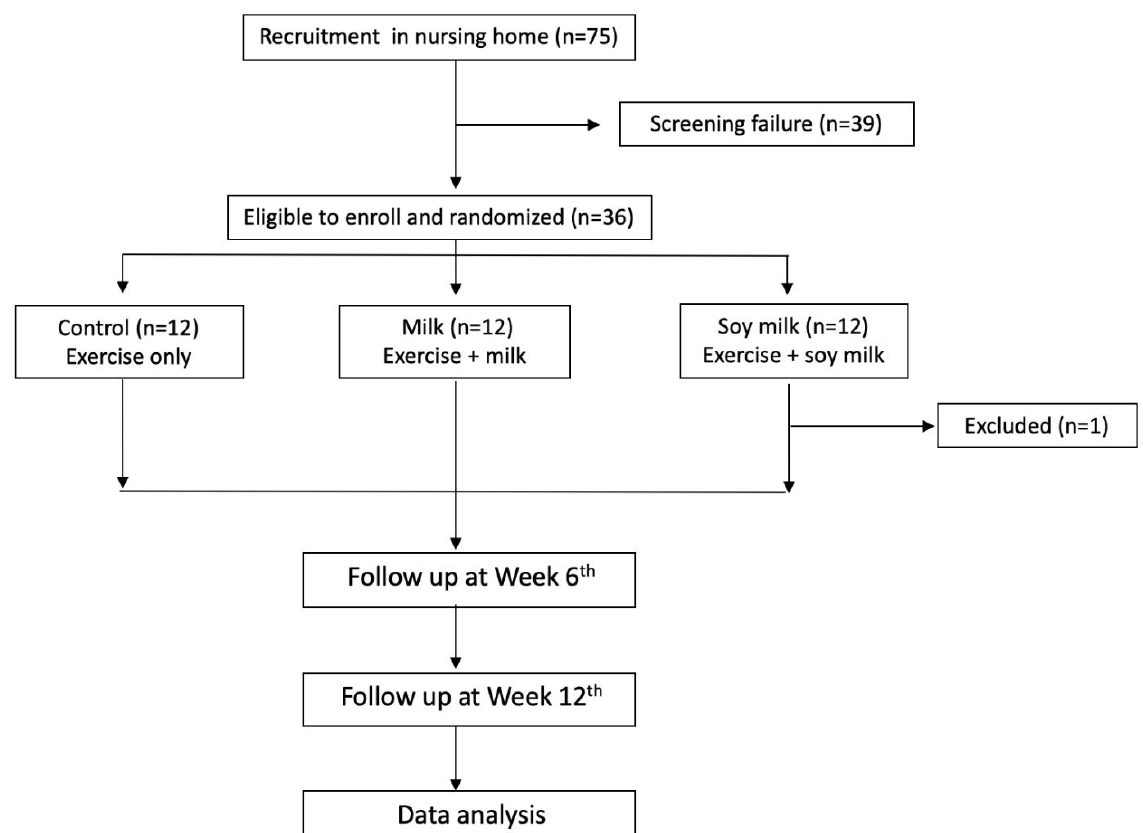
Figure 1. Study flow diagram for enrolling very old (>75 years of age) subjects with sarcopenia in a nursing home from June to December 2017. Thirty-six elderly were recruited and divided into three groups: control ( n = 12), milk ( n = 12), and soy milk ( n = 12) groups. However, one subject ( n = 1) was excluded from soy milk group due to bellyache after drinking soy milk. All participants joined a resistance exercise training program three times per week (30 min/time). Elderly subjects in the milk and soy milk groups drank 200 mL of milk or soy milk for breakfast and as a snack after exercise.